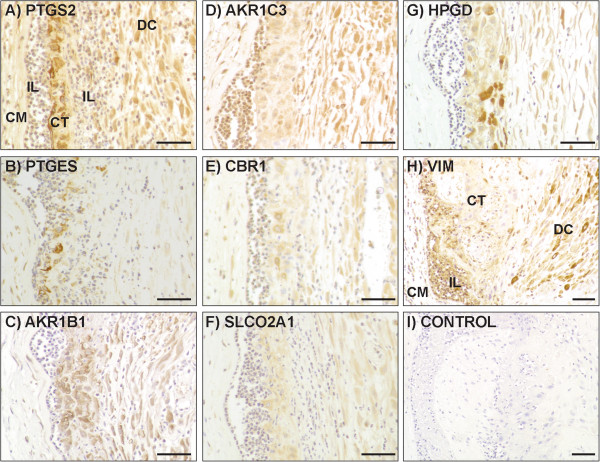
Immunohistochemical localisation of PG pathway proteins in gestational membranes with inflammatory infiltration. (A-I) Images show sections of membranes with chorionic fibroblasts (CF), infiltrating leukocytes (IL), chorionic trophoblast (CT) and decidual cells (DC). (I) Negative control without addition of primary antibody. Scale bar = 50 μm.